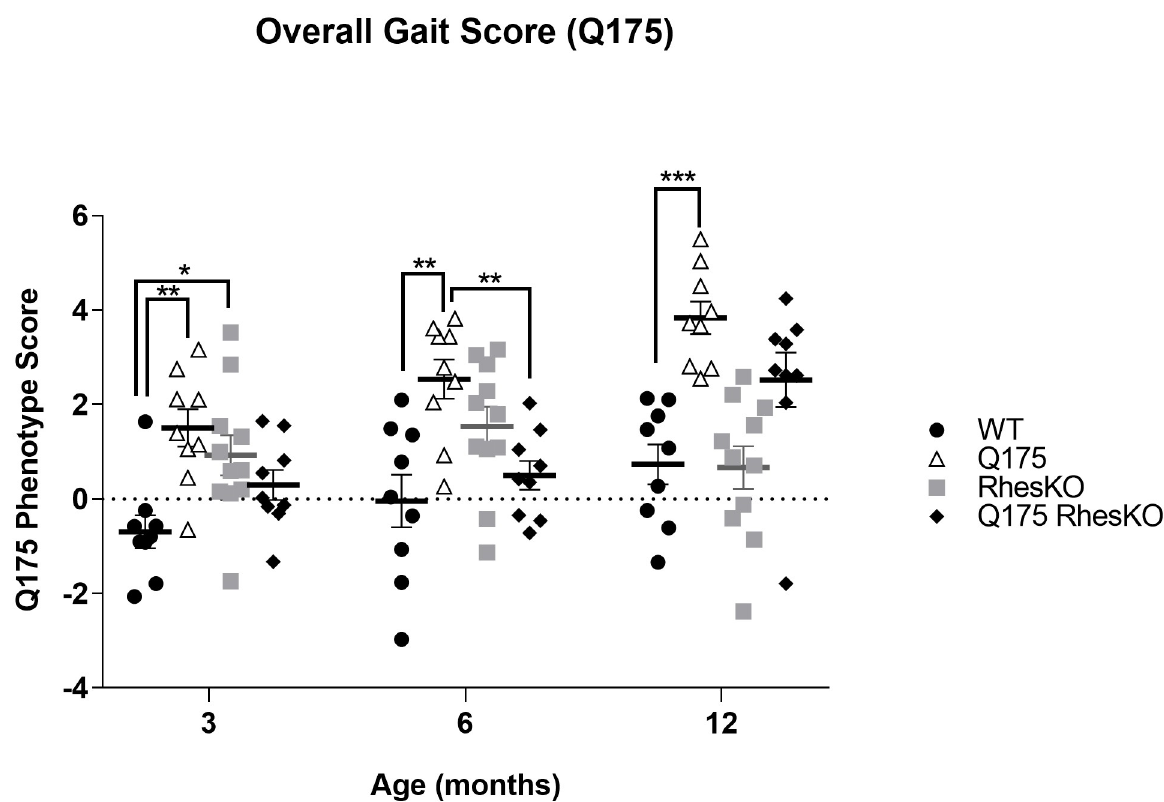
Fig 3. Overall gait score in Q175 female mice. The overall gait score based on differences between Q175 and WT was identified. Scores project normalized parameter data of each mouse onto the discriminant vector; two-way mixed ANOVA followed by Tukey’s test (WT n = 9; RhesKO n = 11; Q175 n = 9; Q175;RhesKO n = 9); Two-way mixed ANOVA followed by Tukey’s test, � p < 0.05, �� p � 0.01, ��� p < 0.001.